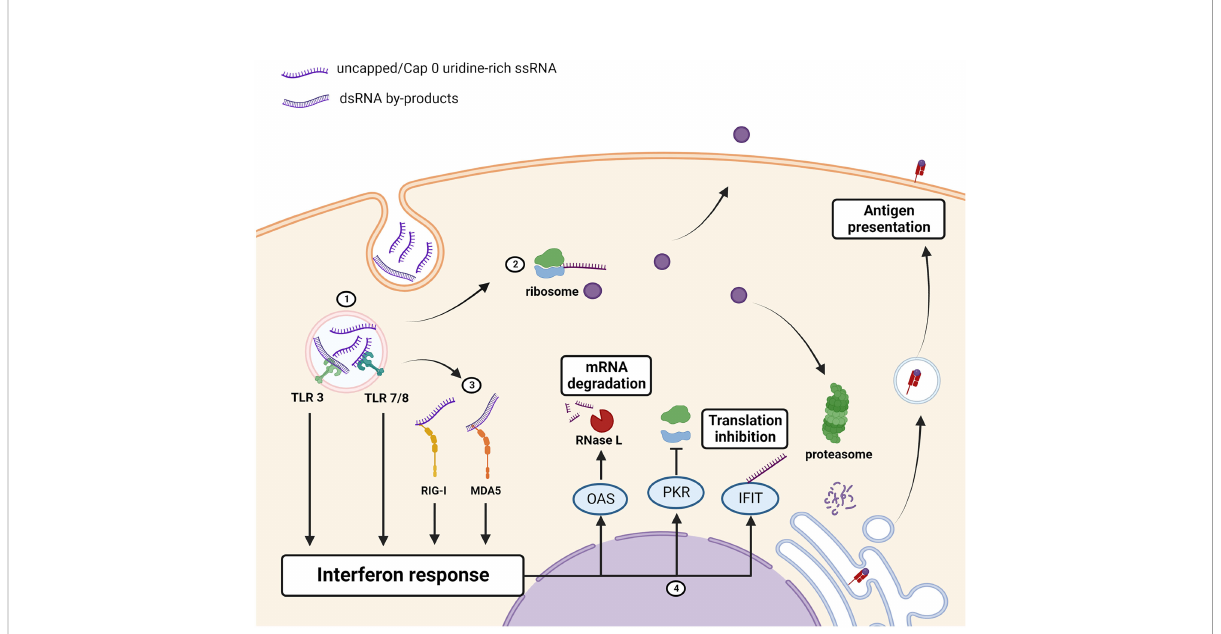
FIGURE 2 Immunogenicity of unmodi fi ed mRNA therapeutics/antigen. (1) Uridine-rich ssRNA and dsRNA IVT by-products, taken up by the cell through endocytosis, are sensed by toll-like receptors (TLRs) which induce an interferon response. (2) mRNA is translated into the protein of interest which can be retained intracellularly, displayed on the cell-membrane, or secreted. The protein of interest is also processed and bound to MHC for antigen presentation to the adaptive immune system. (3) Cytosolic PRRs RIG-I and MDA5 detect the presence of uncapped, uridine rich, or dsRNA and augments the interferon response. (4) Interferon-stimulated genes encoding antiviral proteins OAS, PKR and IFITs are upregulated. OAS activates RNase L which cleaves RNAs, PKR inhibits ribosome recruitment, and IFIT binds to uncapped or cap 0 mRNAs to prevent translation thus reducing the amount of the protein that is produced. Created using